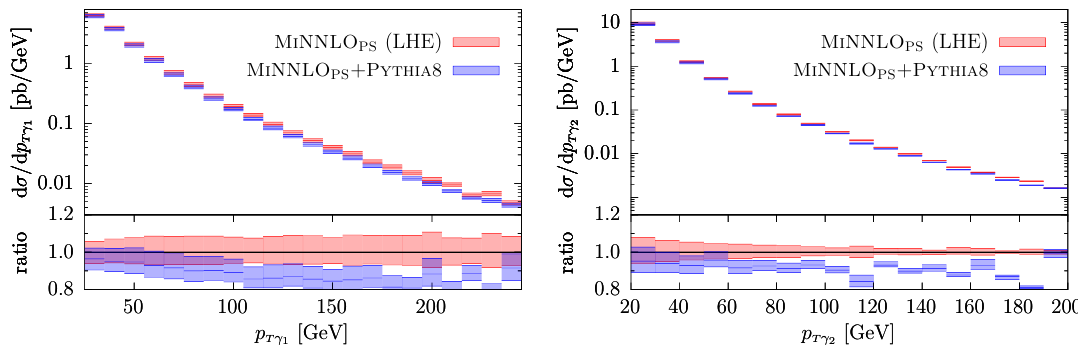
Figure 8 . Comparison between the distributions obtained from the Powheg events before and after the Pythia8 parton shower for the transverse momentum of the hardest and next-to-hardest